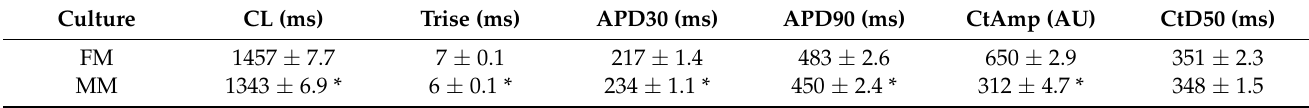
Table 1. Overview of the relevant baseline parameters of the two different models. This table represents the most relevant parameters obtained from the two types of biomarkers (electrophysiology and contractility). Cycle length (Cl), rise time (Trise), action potential duration (APD) at 30% and 50%, contractility amplitude (CtAMP) and contractility duration at 50% amplitude (CtD50).